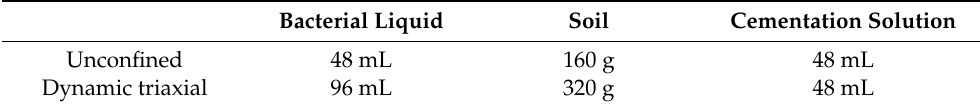
Table 2. The amount of each substance consumed in the preparation of a single sample. Bacterial Liquid Soil Cementation Solution